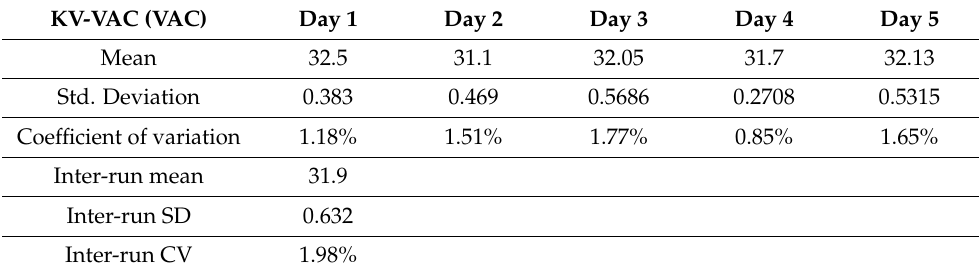
Table 9. Repeatability and reproducibility of the KV-VAC